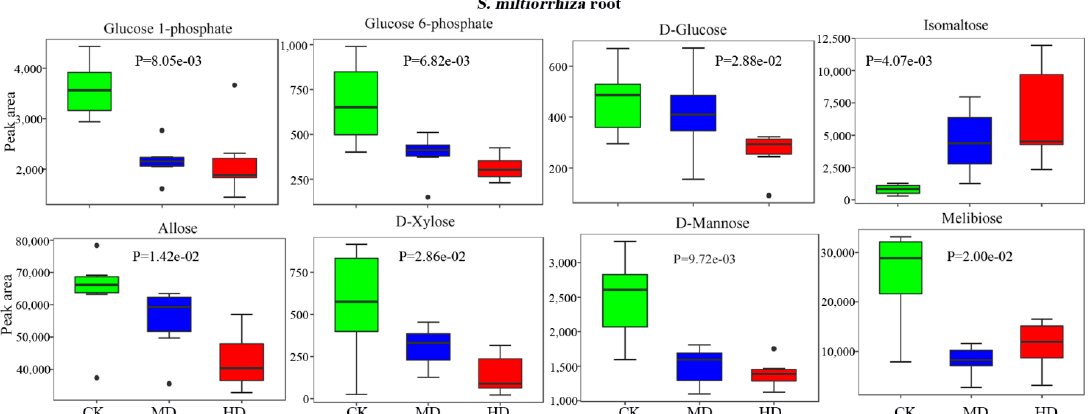
Figure 5. Metabolic profiles of glycolysis metabolites and carbohydrate metabolites in Salvia miltiorrhiza Bunge root. CK: control. MD: moderate drought. HD: high (severe) drought. Univariate statistic method Kruskal–Wallis H test was used to analyze the different levels of metabolites. Data were expressed as median and range (interquartile range).